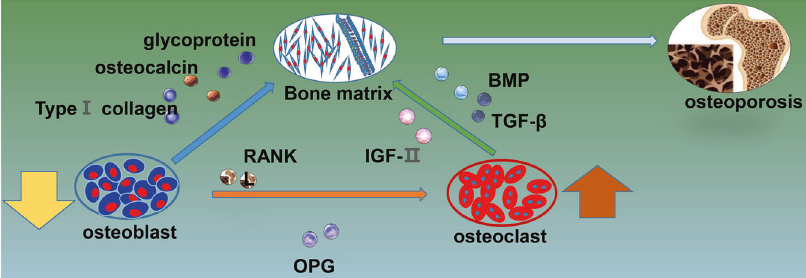
Fig. 2 Molecular mechanism of the pathological process of osteoporosis. The pathological progress of osteoporosis is due to the imbalance between bone regeneration and bone resorption mediated by osteoblasts and osteoclasts. OPG osteoprotegerin, BMP bone morphogenetic protein, TGF- β transforming growth factor- β , RANK receptor activator of nuclear factor- κ B, IGF-II insulin-like growth factor